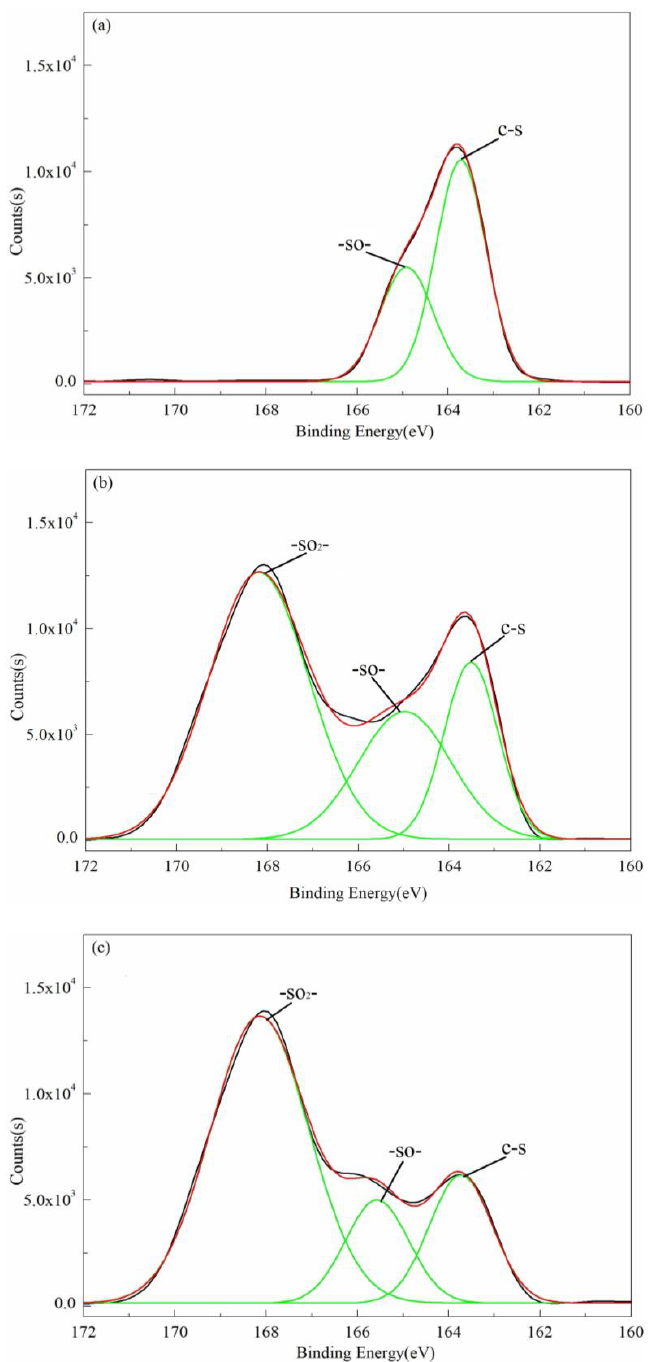
Figure 9. XPS spectra of S 2p in the pure PPS and PPSBM 1 composites: ( a ) pure PPS before treatment, ( b ) pure PPS after treatment, ( c ) PPSBM 1 composites after treatment.